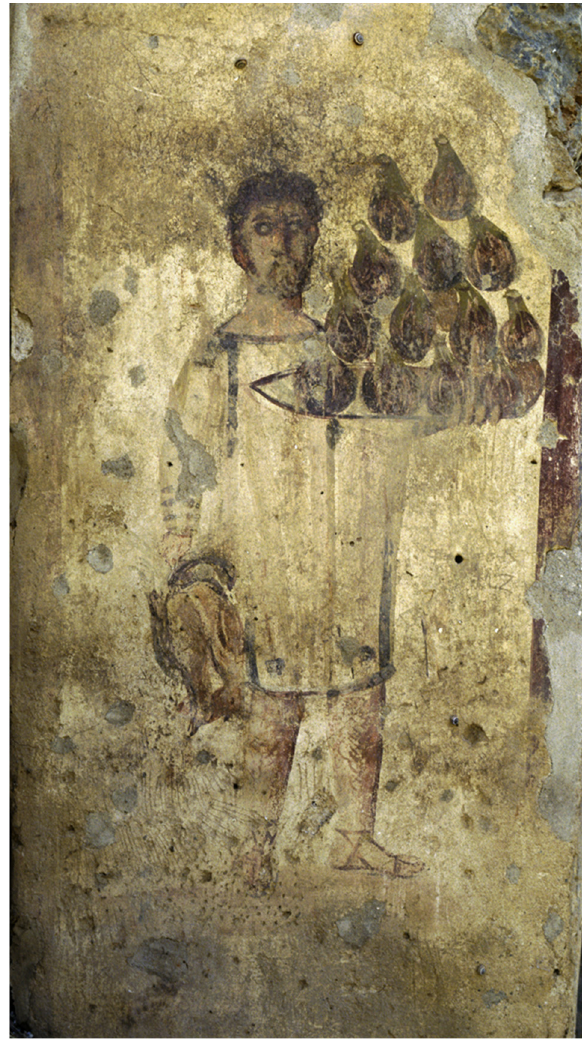
Figure 6. Wall painting depicting a servant holding a plate of figs and a slaughtered fowl, 4th century CE. Ephesos, Odeion Terrace House. Photo: OeAW-OeAI/Norbert Zimmermann.